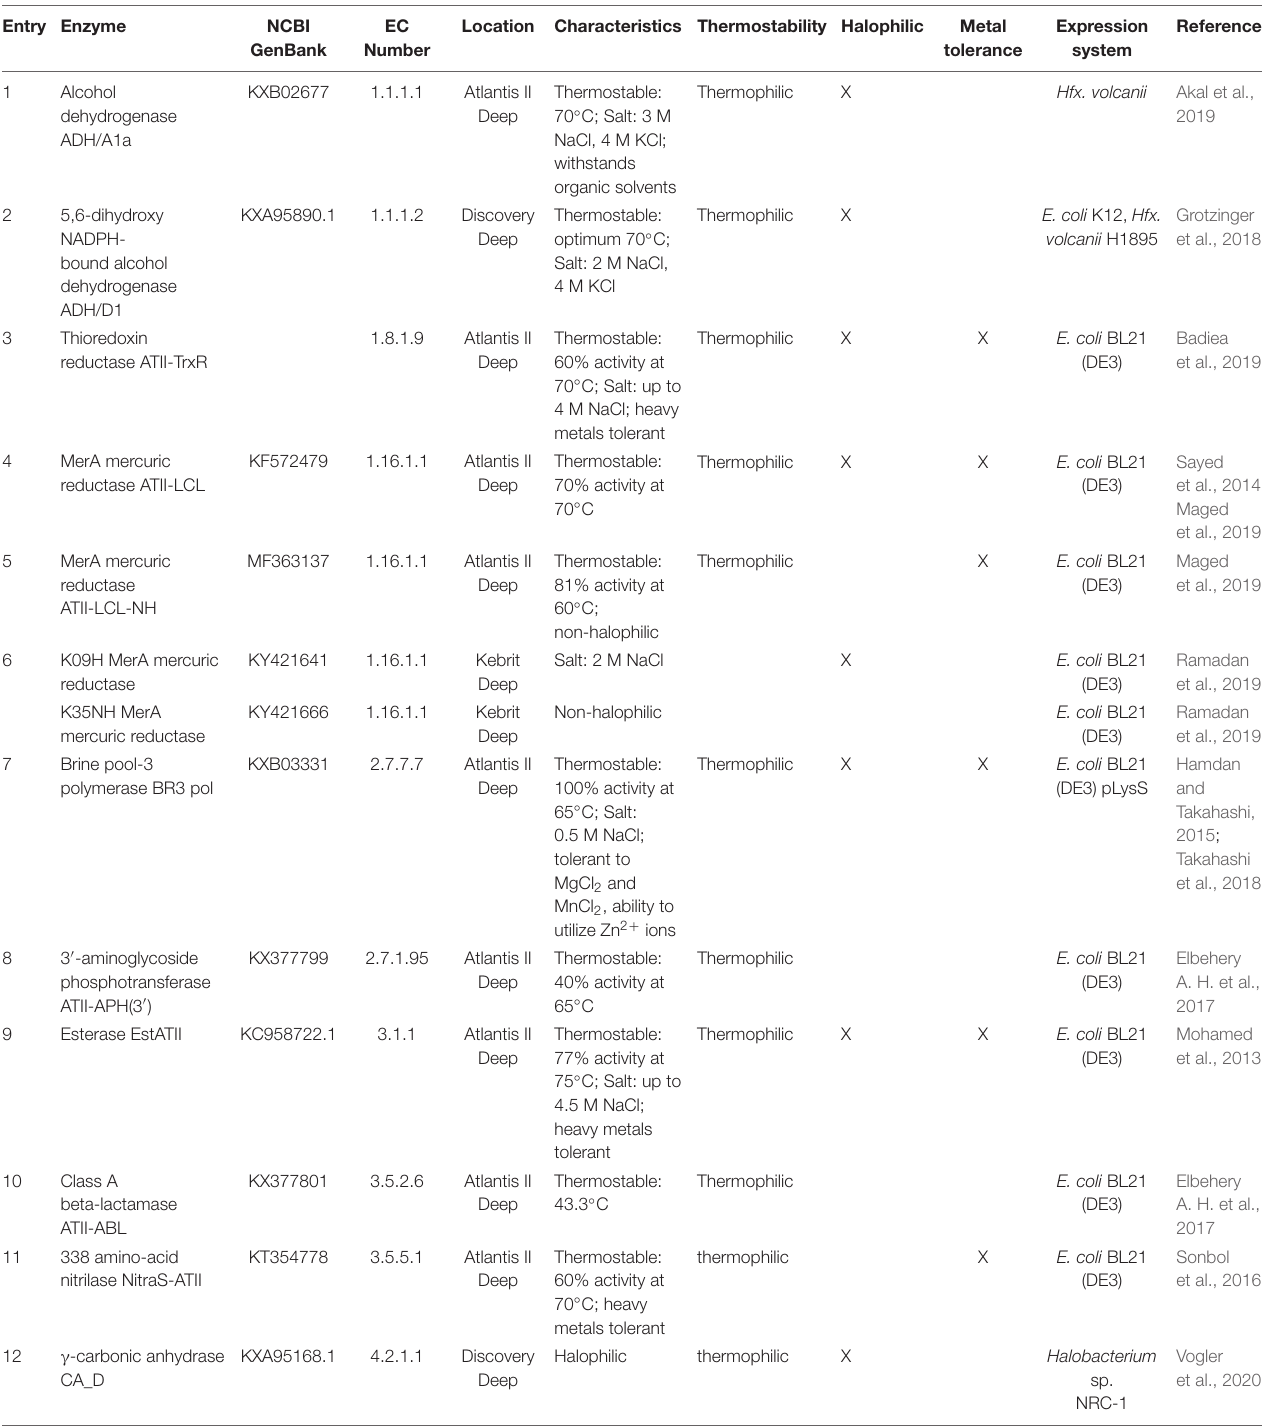
TABLE 1 | Extremozymes from the Red Sea brine